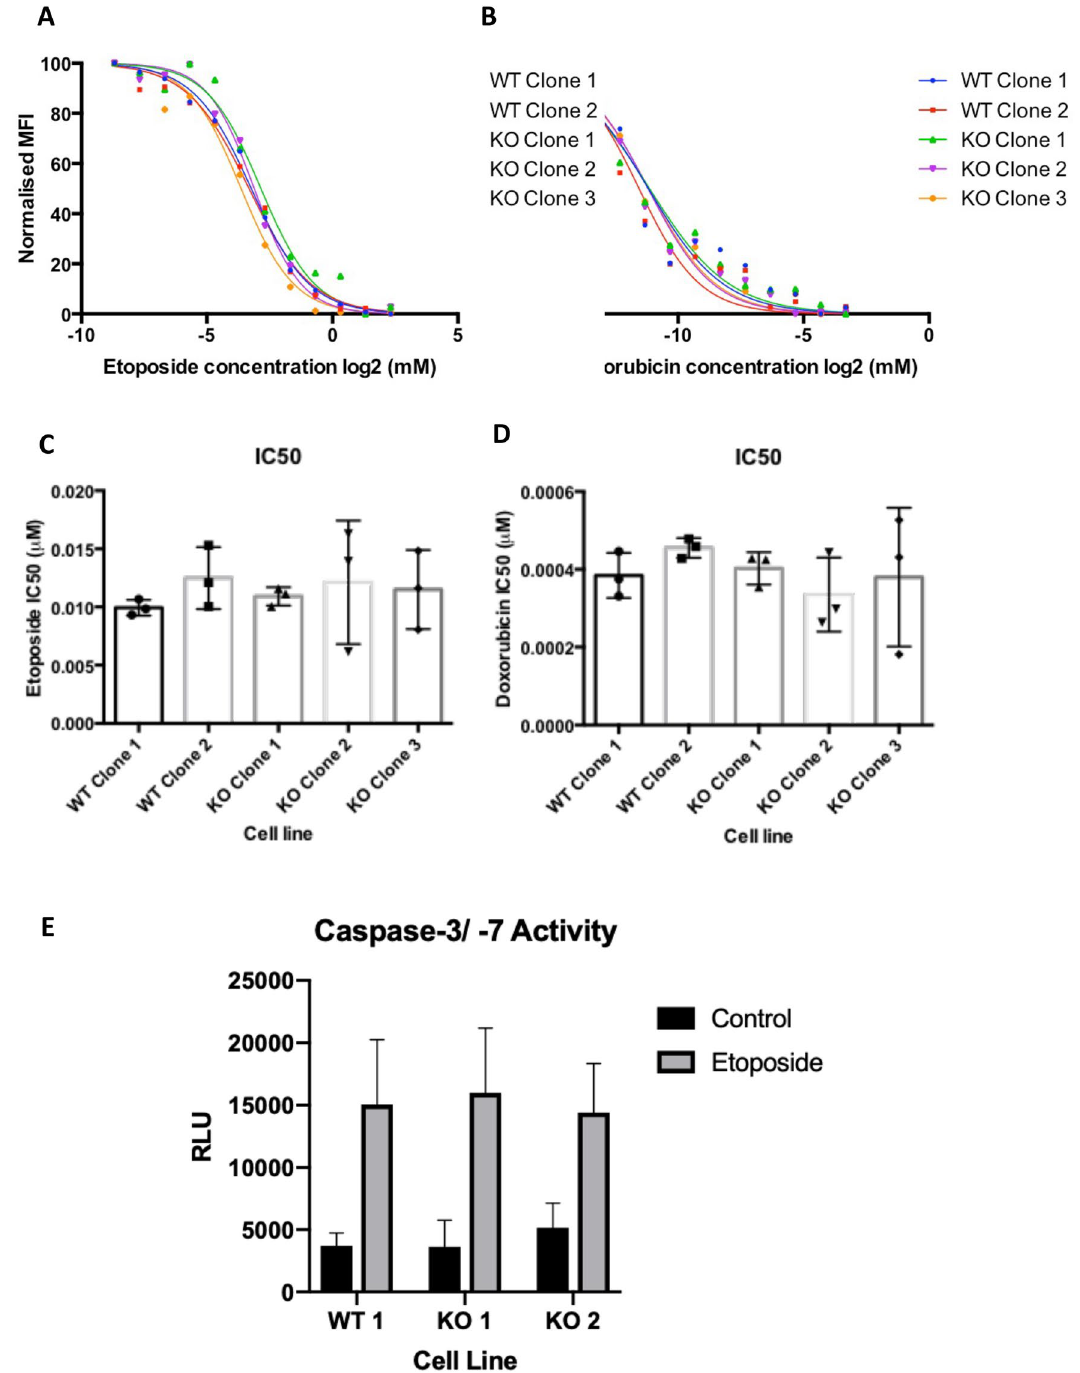
Figure 2. XIAP status does not alter cell viability in response to cytotoxic agents. ( A ) U2OS clonal cell lines were exposed to etoposide for 48 h and viability was determined by PrestoBlue assay. The normalised mean fluorescence intensity (MFI) at increasing concentrations of etoposide (log2(mM)) of three independent experiments for each clone is averaged and plotted (Individual repeats shown in Supp Fig. 1A). Statistical analysis performed using a one-way ANOVA with Dunnett’s multiple comparisons test. ( B ) As in A but using doxorubicin. ( C ) The mean normalised IC50 (mM) for etoposide is plotted for each clone. ( D ) As in C. but for doxorubicin. ( E ) U2OS clonal cell lines treated with 50uM Etoposide for 24 h as indicated. Caspase-3 -7 activity was determined by Caspase-Glo assay and values normalised to untreated controls. Error bars represent standard deviation. Statistical analysis performed using a one-way ANOVA with Dunnett’s multiple comparisons